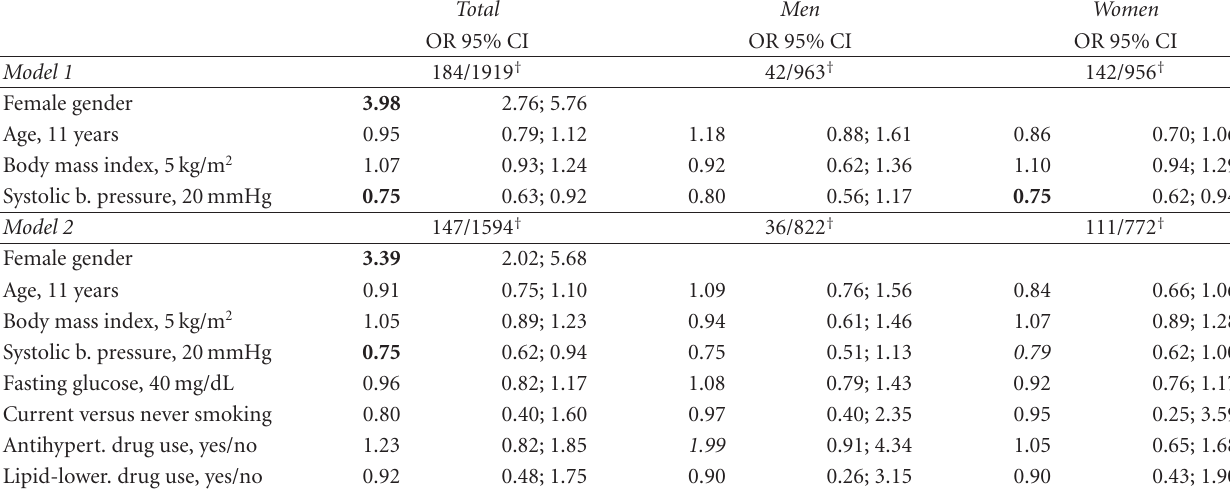
Table 3: Logistic regression analysis for the association of certain parameters with individuals consulting a physician, by